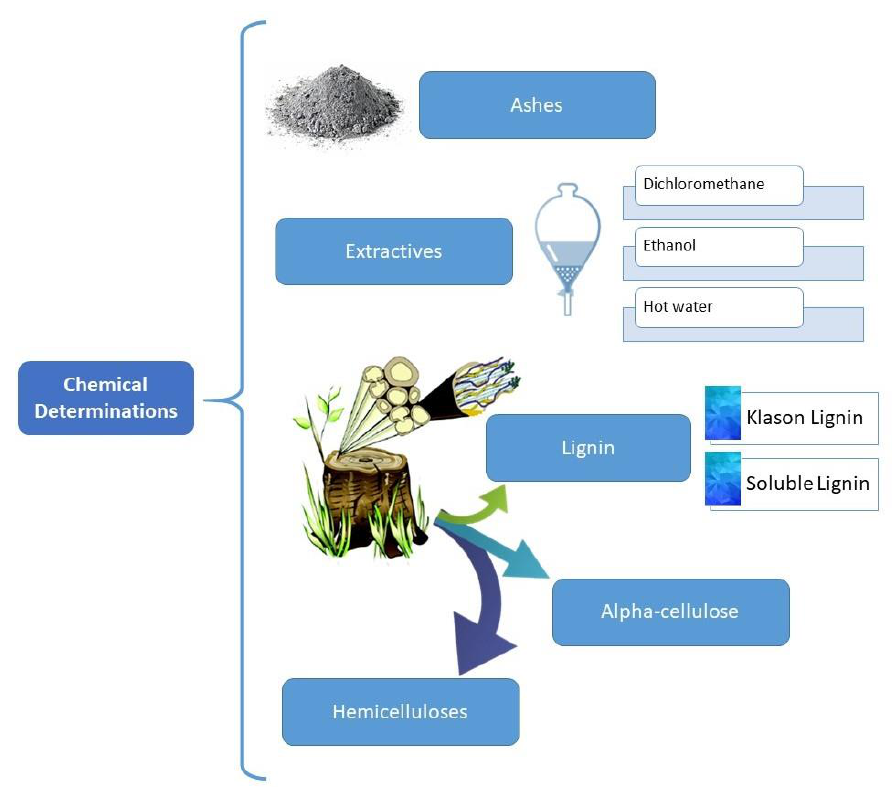
Figure 1. Scheme of the determination of the chemical composition of SCS.